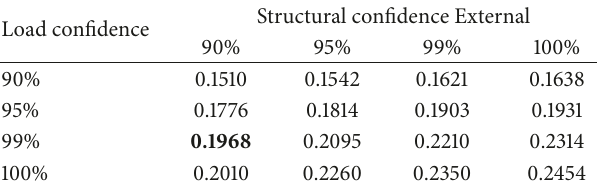
Table 11: Confidences of junction gap (mm). Load